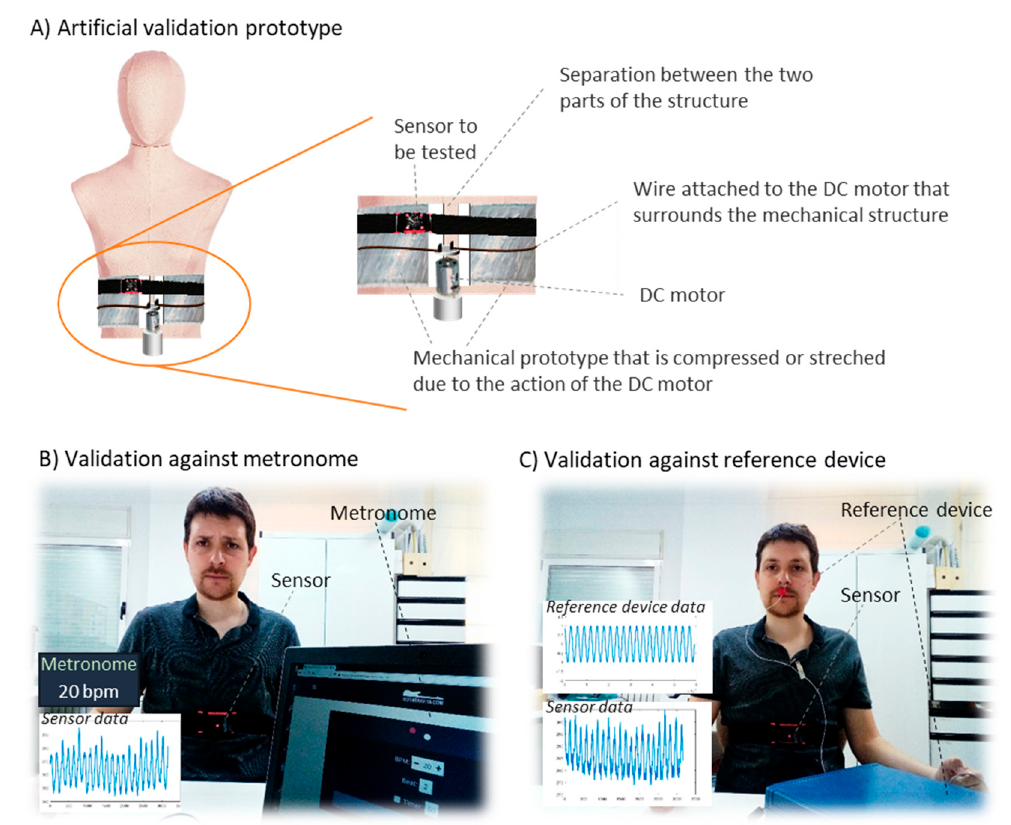
Figure 25. Representation of different validation approaches: ( A ) use of artificial validation prototypes, ( B ) validation using a metronome, and ( C ) validation using a reference device.